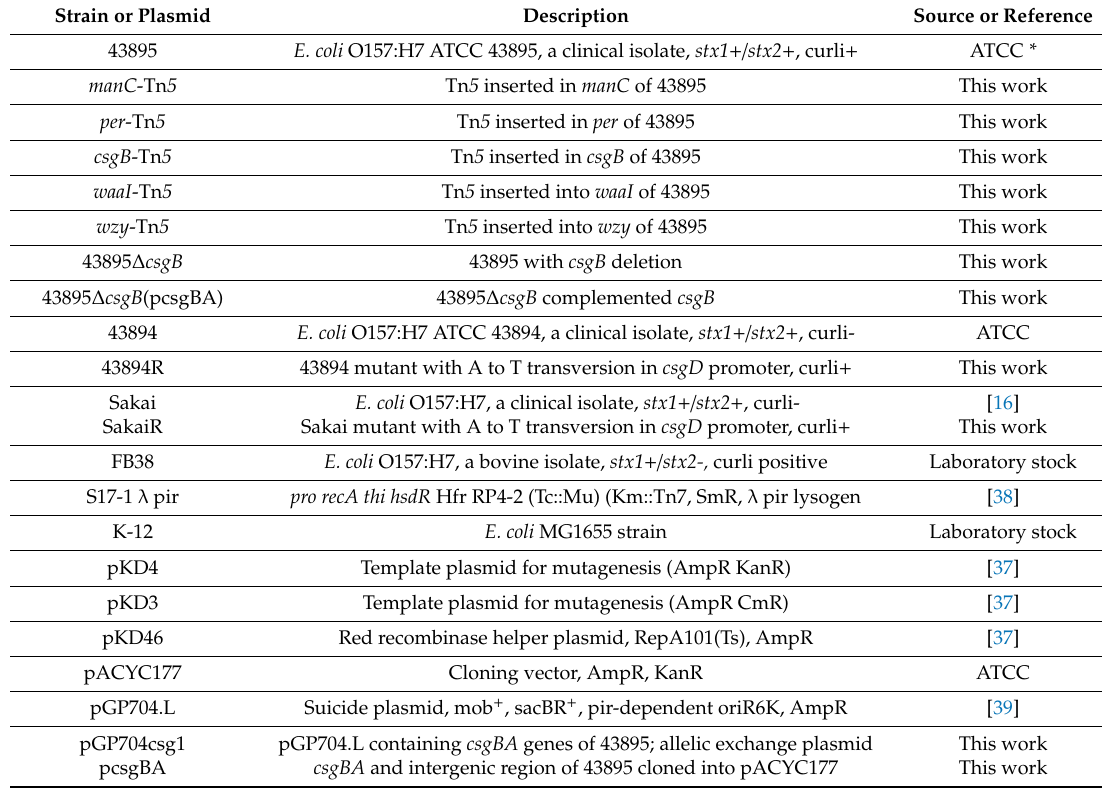
Table 1. E. coli strains and plasmids.